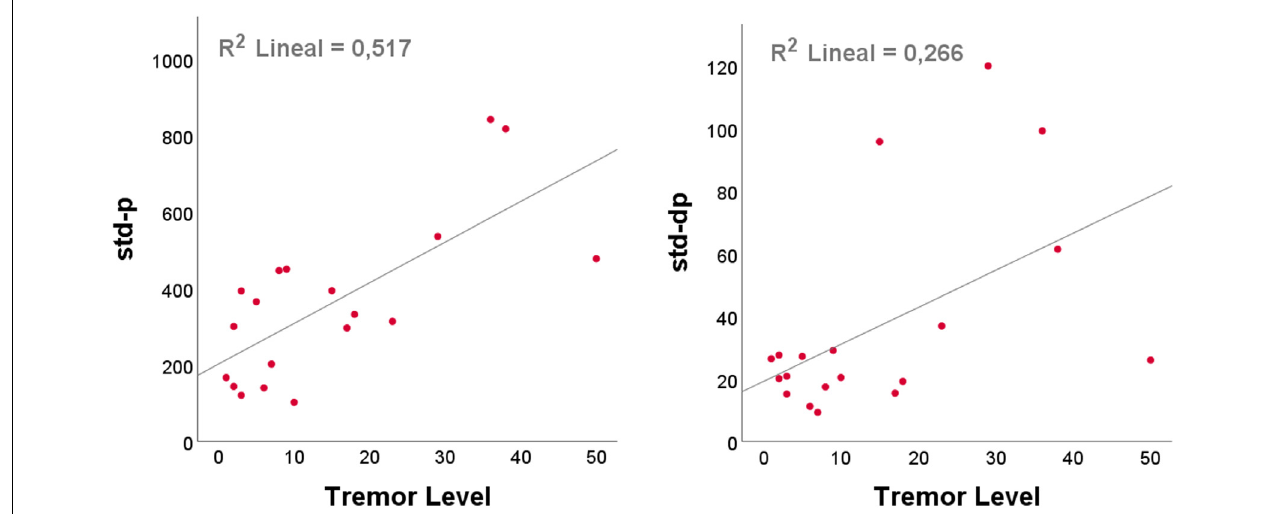
FIGURE 6 | Scatterplots of handwriting features against tremor level with the best linear line fit, determined using ordinary least squares (OLS, SPSS): (left) standard deviation (std) of the pressure; (right) std of the pressure variation.